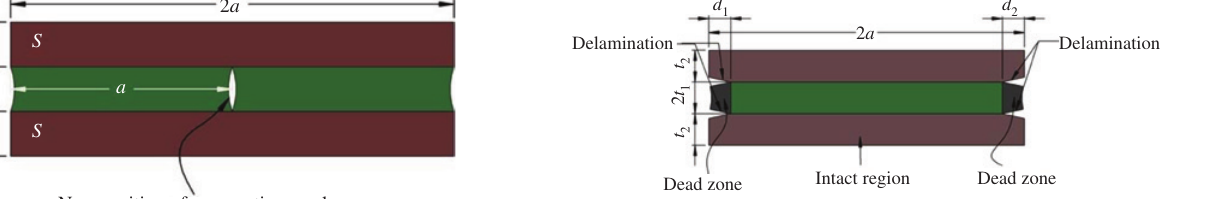
Figure 3: Unit cell after matrix cracking.